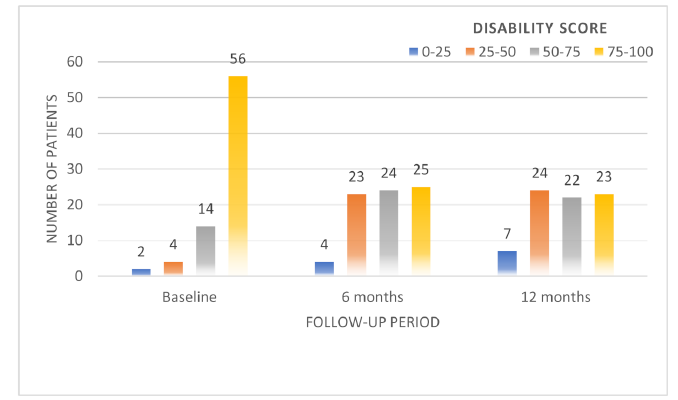
Figure 4. The distribution of Von Korff disability scores over one year. The initial pain intensity score was found to be between 75 and100 in 45 patients (59.2%), between 50 and75 in 25 patients (32.9%), and between 25 and50 in 4 patients (5.3%). Only 2 (2.6%) patients had a score of less than 25 points. Pain severity decreased considerably at the 6-month follow-up, from 59.2% to 10.5% ( p < 0.001), and remained elevated at the 1-year follow-up, at 11.8%. A disability score higher than 75 was reported by 73.7% of the patients in the hospital,